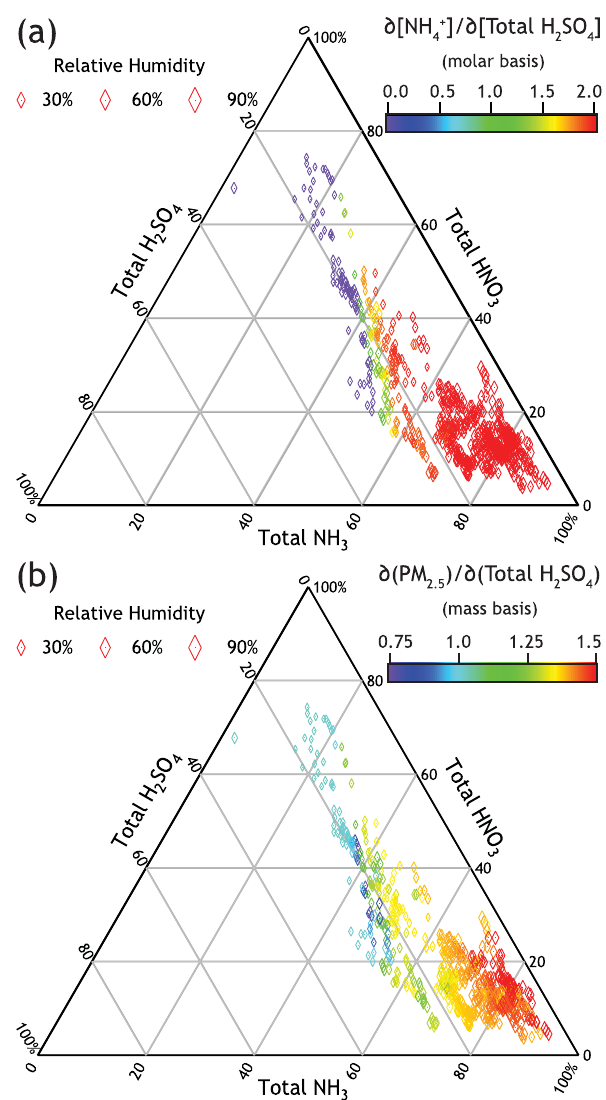
Fig. 8. ANARChE data processed with ANISORROPIA reveal At- ] ∂ [ NH + 4 ( aq ) (molar basis) (a) and lanta ∂ [ TotalH 2 SO 4 ] sis) (b) in July–August 2002. RH ranges from 25%–99% and tem- perature from 293K to